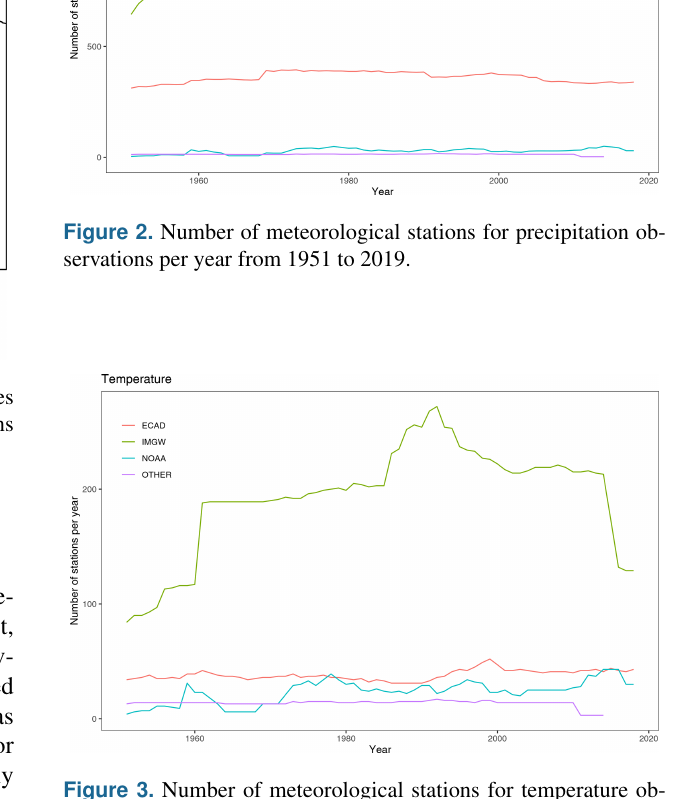
Figure 3. Number of meteorological stations for temperature ob- servations per year from 1951 to